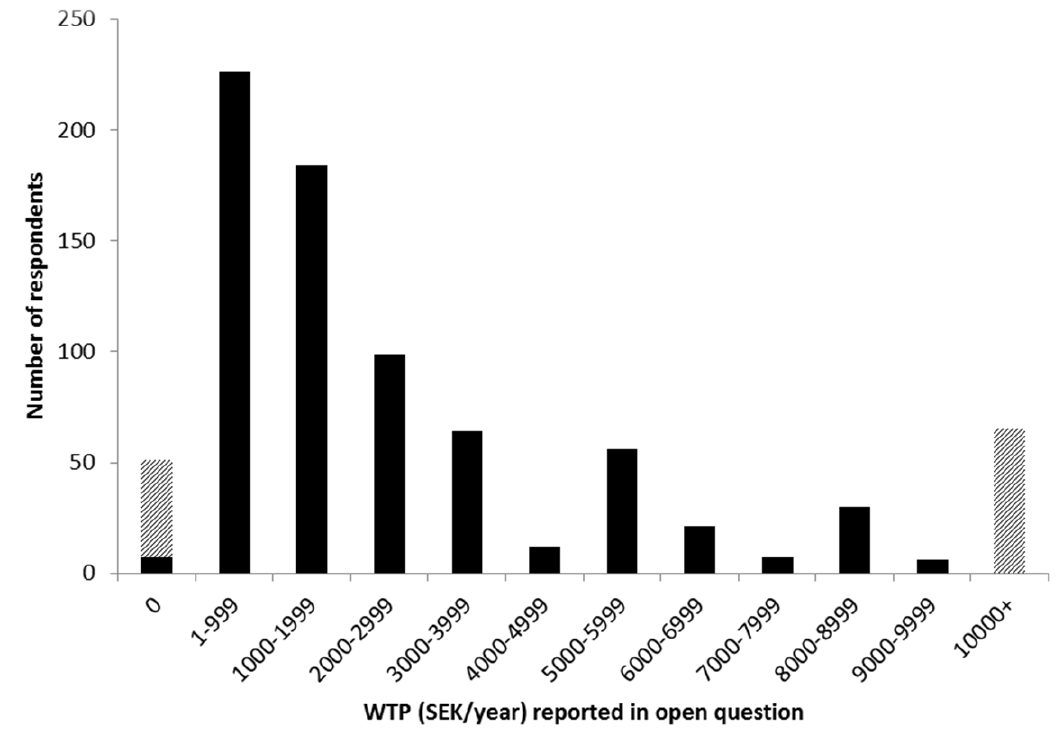
Figure 4: Frequency distribution of the answers to the open WTP question, striped bars represent respondents who were excluded from the base-case analysis